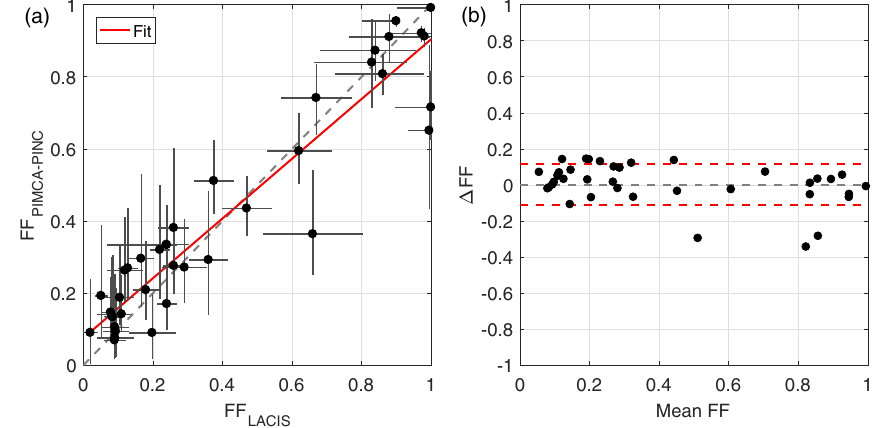
Figure 3. (a) Correlation of frozen fraction for all aerosol types measured between PIMCA-PINC and LACIS. Data are binned in 1K intervals for the correlation. The dashed line represents the 1 : 1 line and the red line is a linear fit to all samples. (b) Differences between PIMCA-PINC and LACIS are shown as a function of their mean FF. Dashed red lines show the standard deviation (1 σ )